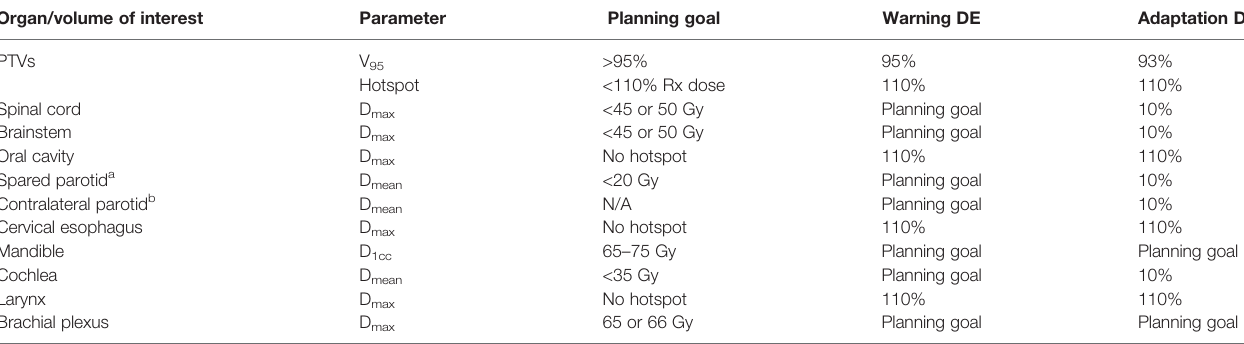
TABLE 3 | Treatment planning dose constraints and structure speci fi c dosimetric endpoints (DE) . Organ/volume of interest